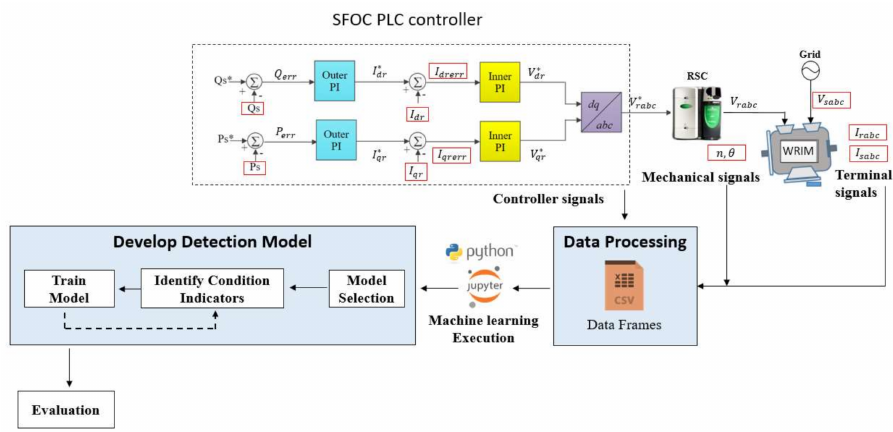
Figure 4. Signals extraction on the doubly fed induction generator (DFIG) operation including controller loop, mechanical, and terminals signals.